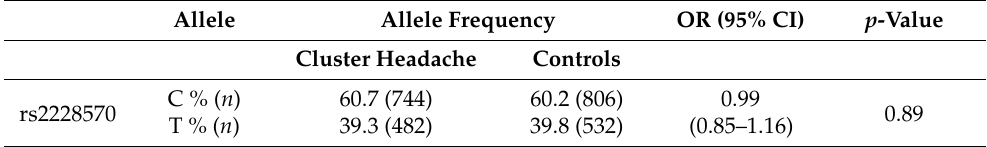
Table 2. Allele distribution for vitamin D receptor single-nucleotide polymorphism rs2228570. Allele Allele Frequency OR (95% CI) p -Value Cluster Headache Controls rs2228570